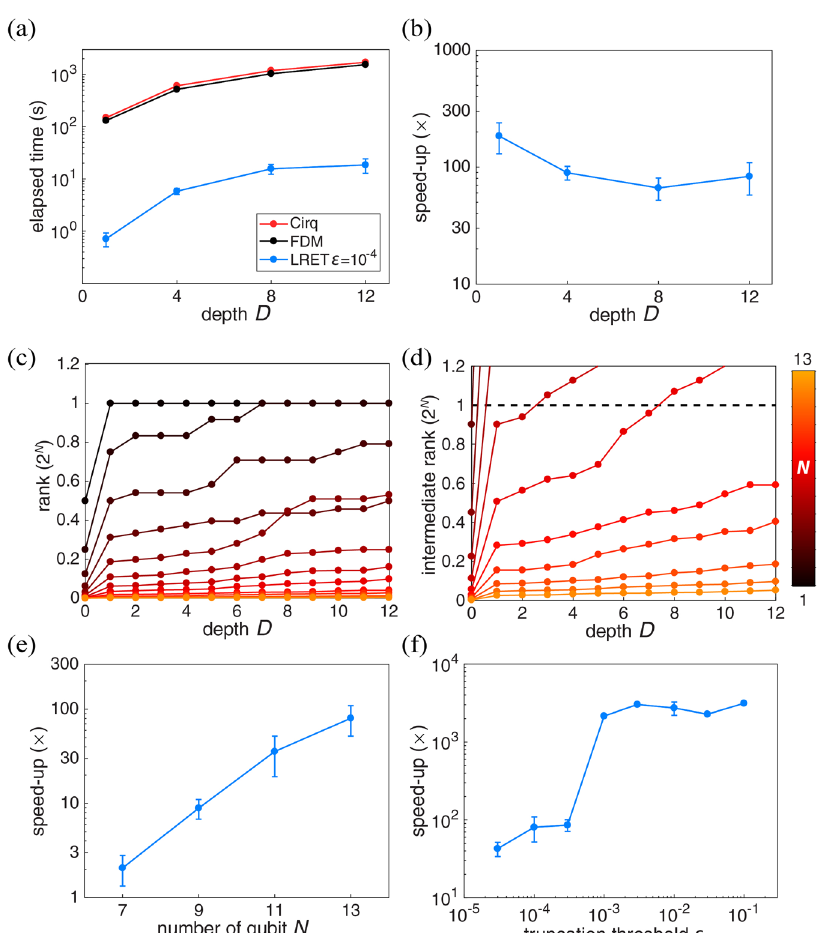
Fig. 3 Time benchmarking under depolarizing noise. a Averaged elapsed time for quantum circuits with N = 13 qubits using different simulators. Error bar is the standard deviation from several random circuits. b Speedup, de fi ned by the ratio of the elapsed time between FDM and LRET, for different circuit depths. c Rank evolution for different size of quantum circuit. d Intermediate rank for different size of quantum circuit. e Speedup for different number of qubit ( D = 13). f Speedup for different truncation threshold ( N = 13, D = 13). Parameters are p = 0.1% and ϵ = 10 − 4 . The error bars are standard-deviation-calculated across a set of